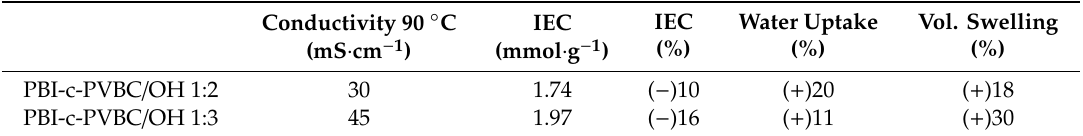
Table 1. Conductivity and ion exchange capacity (IEC) values of the PBI-c-PVBC / OH membranes and variation of properties after the chemical stability test (immersion in 1M KOH solution at 60 ◦ C for 20 days). ( − ) Reduction. ( + ) Increment. Data from [23].